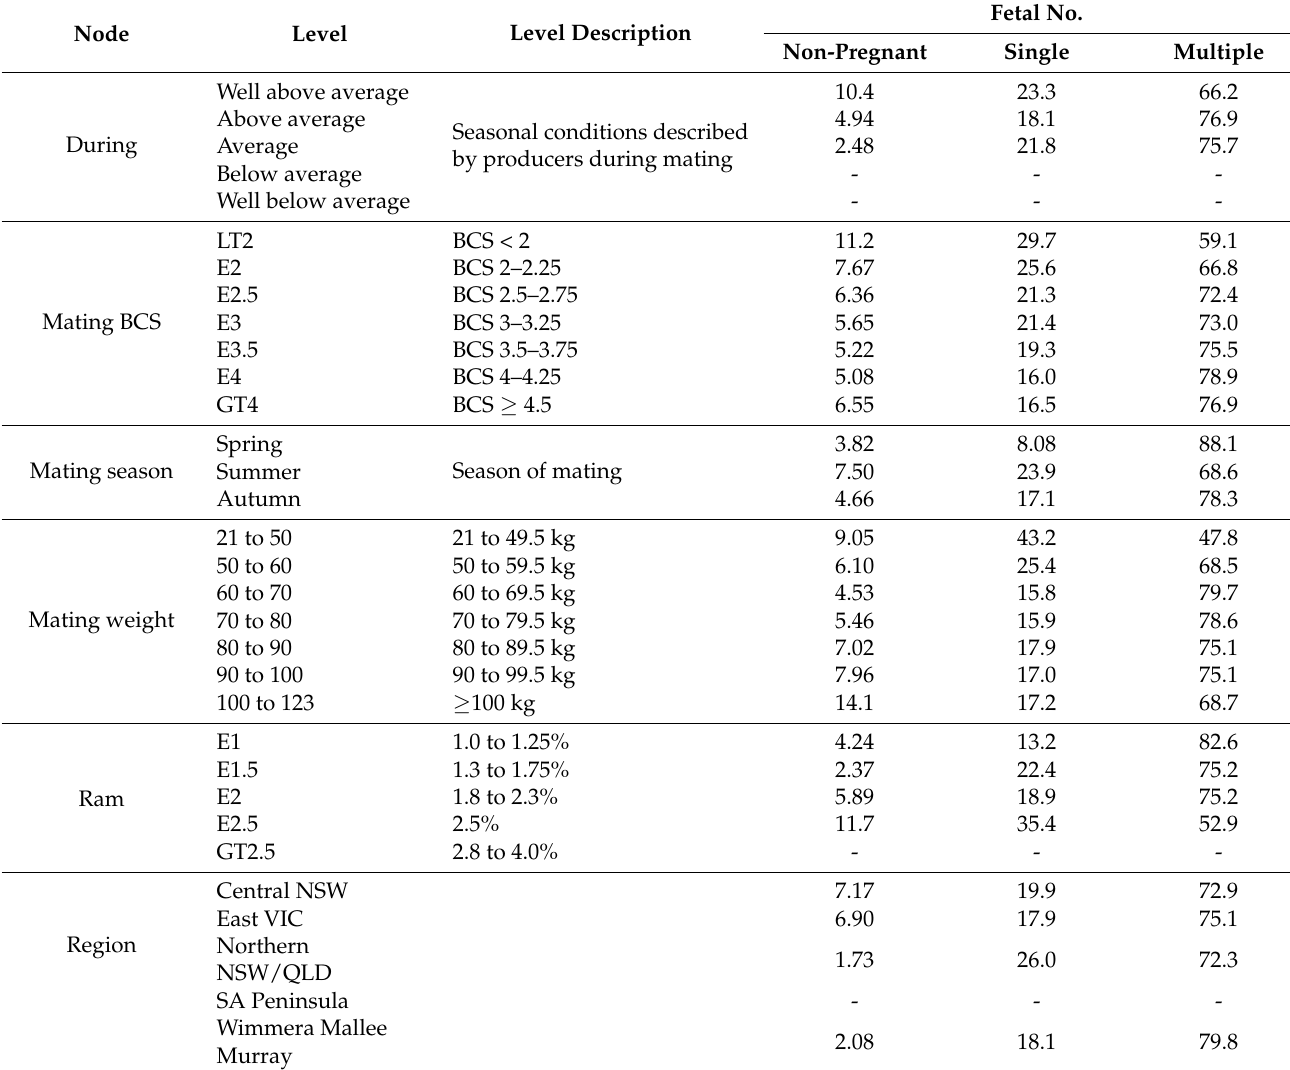
Table 4. The estimated probabilities for Composite fetal number (no., displayed as percentages) for each node (variable) when the different levels within each node are assumed in the Bayesian Network (BN) model, where BCS = body condition score. Level descriptions detail the data and naming conventions within each level of the model. A dash (-) indicates data were not applicable for the respective level. The BN model assessed the interrelationships between pregnancy outcome and fetal number of Composite ewes. Data displayed to three significant figures (rather than decimal places) as such the row total percentage value may be slightly different from 100% due to rounding errors. Letter prefixes are defined as: LT = less than, E = a range of values around the displayed value and GT = greater than. Region abbreviations are defined as: NSW = New South Wales, VIC = Victoria, QLD = Queensland and SA = South